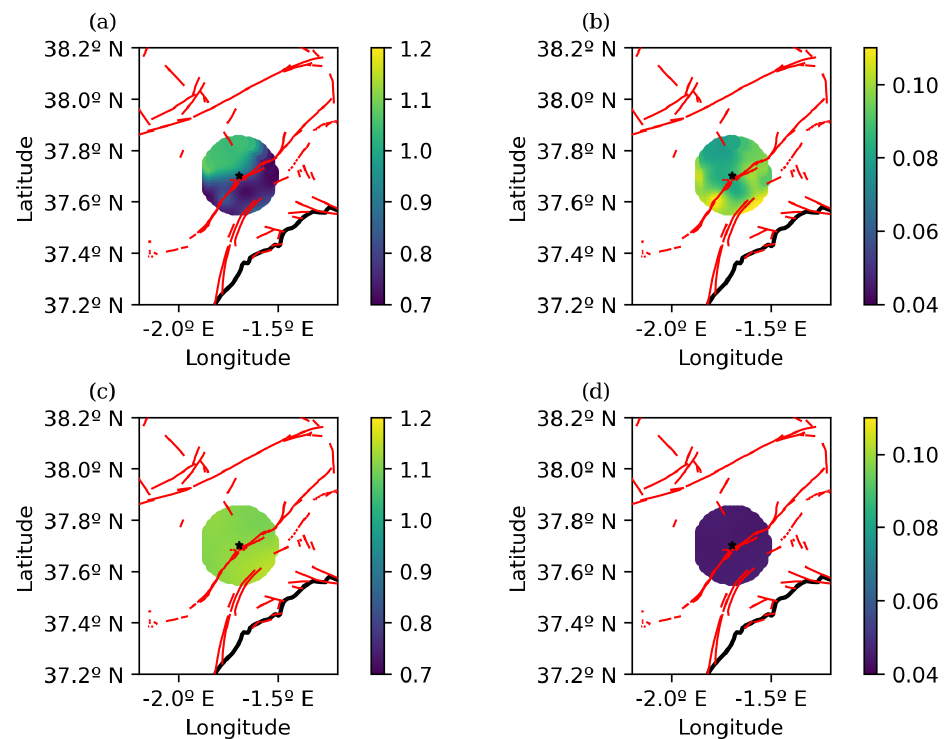
Figure 10. (a) Spatial distribution of the b -value and (b) its uncertainty in the Lorca area using data from 2000 to 2011 and the σ and µ values obtained before. A total of 981 events have been used in the b -value calculation. (c) Spatial distribution of the b -value and (d) its uncertainty in the Lorca area using data from 2011 to 2020 and the σ and µ values obtained in the previous step. A total of 824 events have been used in the b -value calculation. The red lines are the fault traces from QAFI 3.0 (García-Mayordomo et al., 2012) and the black star marker shows the location of the Lorca earthquake